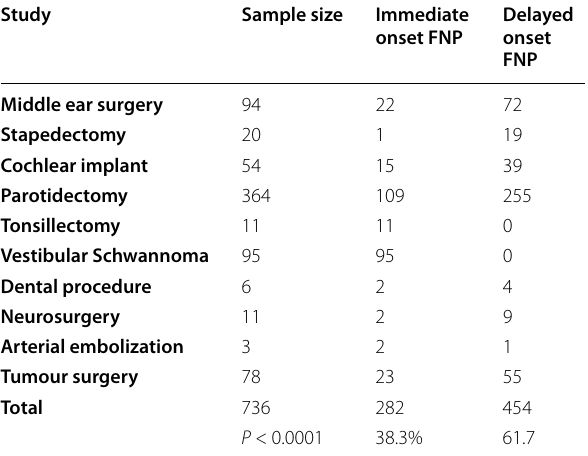
Table 3 Onset of facial nerve paralysis